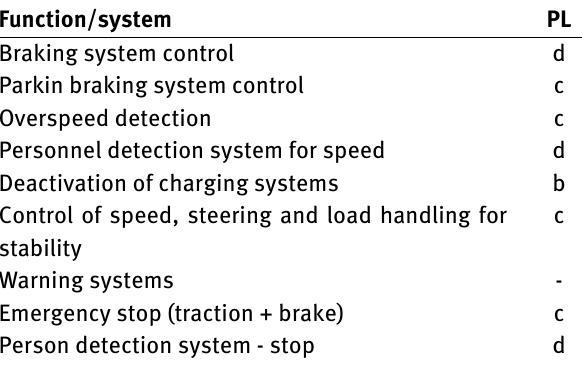
Table 1: Summary of safety functions and their minimum perfor- mance levels according to ISO 13849-1